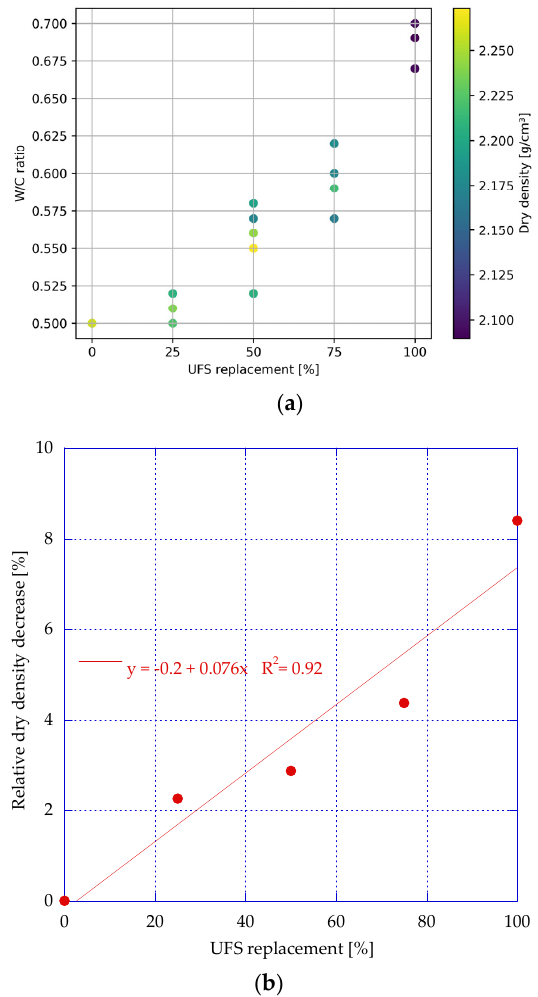
Figure 10. Dry density (g/cm 3 ) of the mortar mixes ( a ) and dry density decrease (%) ( b ).